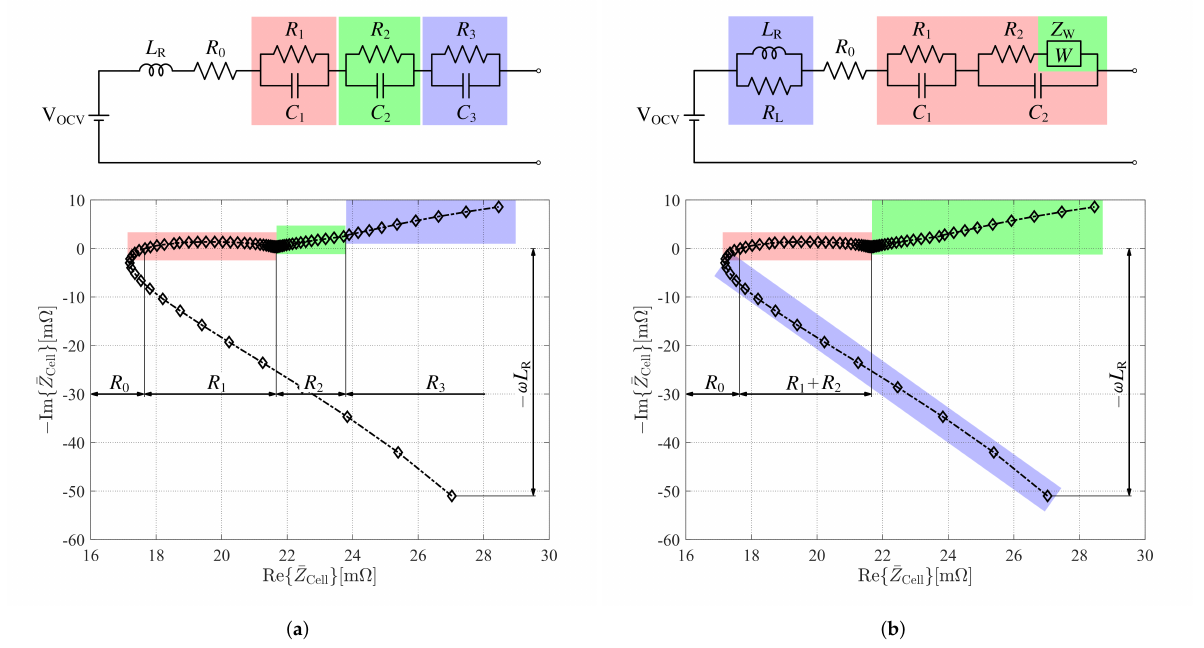
Figure 5. Model of a battery cell with respect to the effect of the model’s individual components on the Nyquist plot. ( a ) Three- RC -pair model. ( b ) Warburg impedance model. In addition to the color highlighting, the labeled arrows represent the resistive and inductive parameters of the equivalent